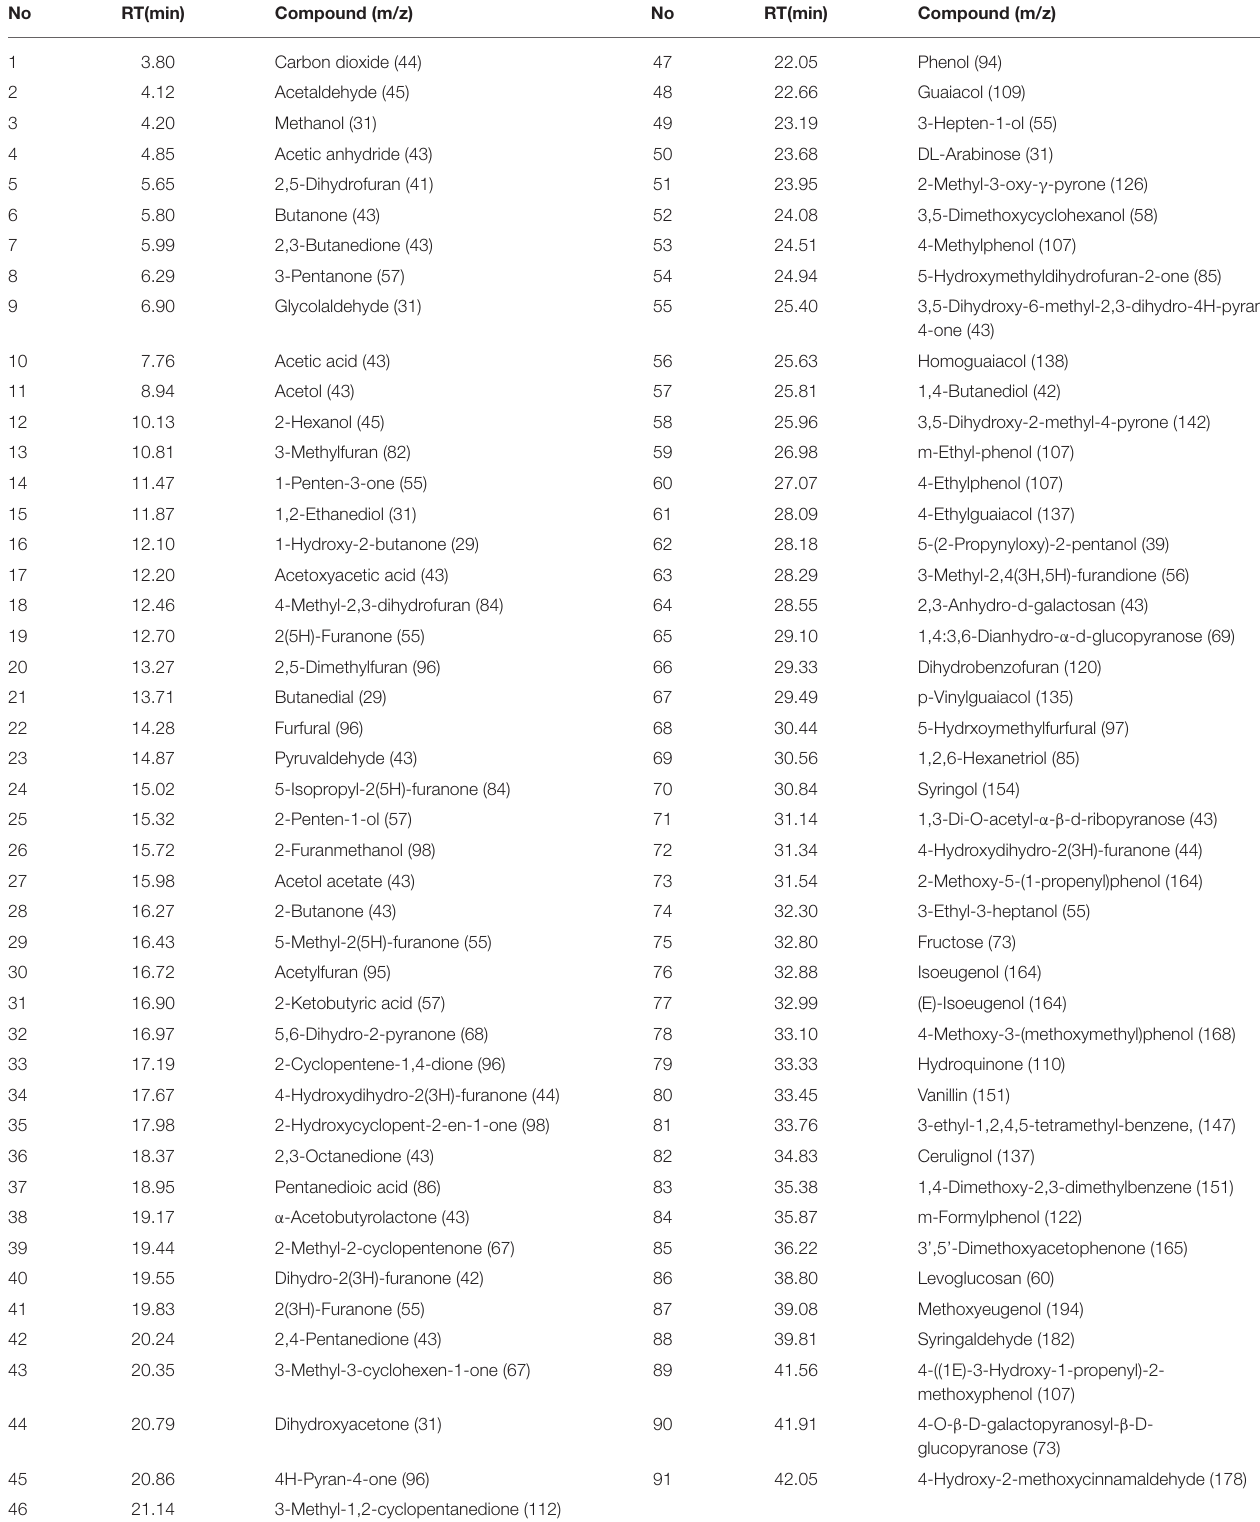
TABLE 2 | Organic compounds identified by Py-GC/MS from the unextracted and the corresponding extractives-free switchgrass